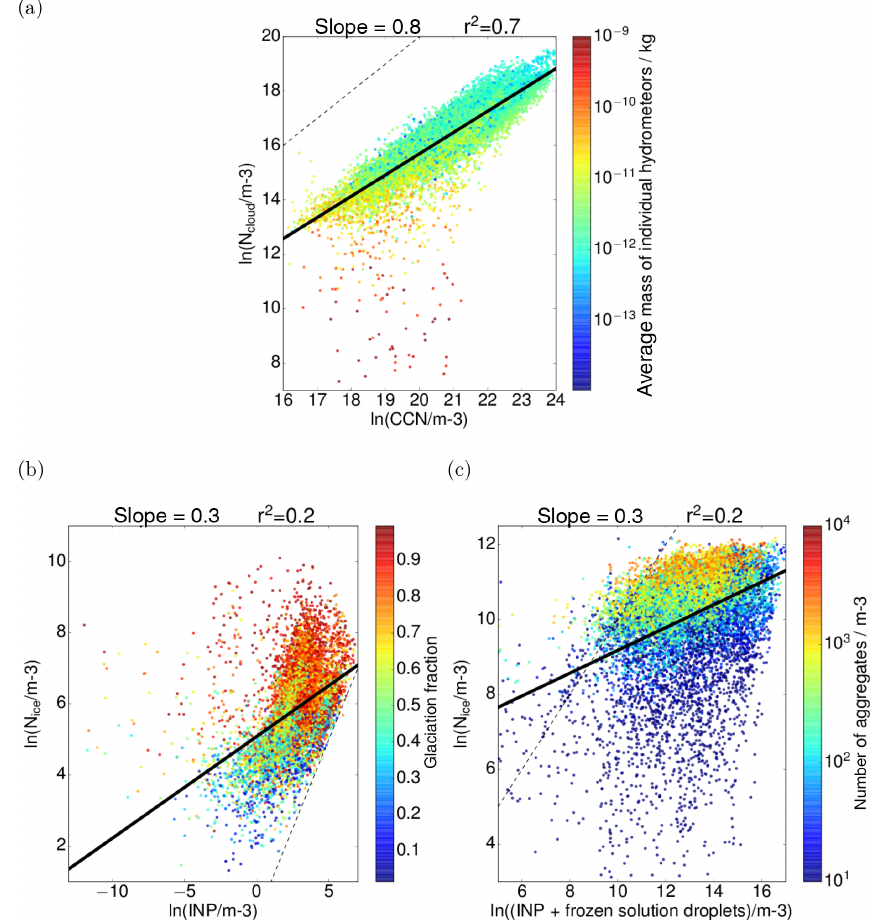
Figure 14. Relationship between CCN/INP and cloud droplet number concentration N cl and ice crystal number concentration N ci . The figures show double logarithmic scatterplots of the cloud droplet number concentration N cl as a function of CCN concentration in liquid clouds (a) and the ice crystal number concentration N ci as a function of INP concentration in mixed-phase clouds (b) and as a function of the combined concentration of INPs + frozen solution droplets in cirrus clouds (c) . Warm and mixed-phase clouds are defined as in Figs. 10 and 12; cirrus clouds are restricted to regions with competition of heterogeneous and homogeneous freezing as indicated by nonvanishing numbers of both INP and solution droplets. Data points represent temporally and vertically averaged values from Coupled simulations with the Phillips ice-nucleation parameterization at every grid point (see text for details). Only every fifth data point used for the fit is displayed. Solid black lines illustrate least-square fits with slope and coefficient of determination r 2 as indicated in plot titles. All fits are significant. Black dashes indicate 1:1 lines. Colors denote the mass of individual hydrometeors, averaged over all cloud droplets and rain drops (a) , the glaciation fraction, i.e., the ratio of frozen to total cloud water (b) , and the number of ice crystal aggregates (c)